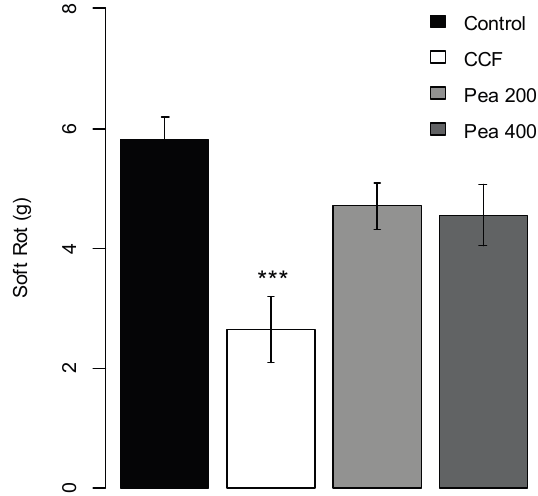
Figure 2. Protection effect of CCF (400 µg/slice) and pea (200 and 400 µg/slice) measured on potato tubers slices against Pectobacterium atrosepticum . Values are means of replicates of two independent experiments ± standard error. Bars with different stars subscripts are significantly different from control (water) (Tukey HSD, *** p = 0.001).